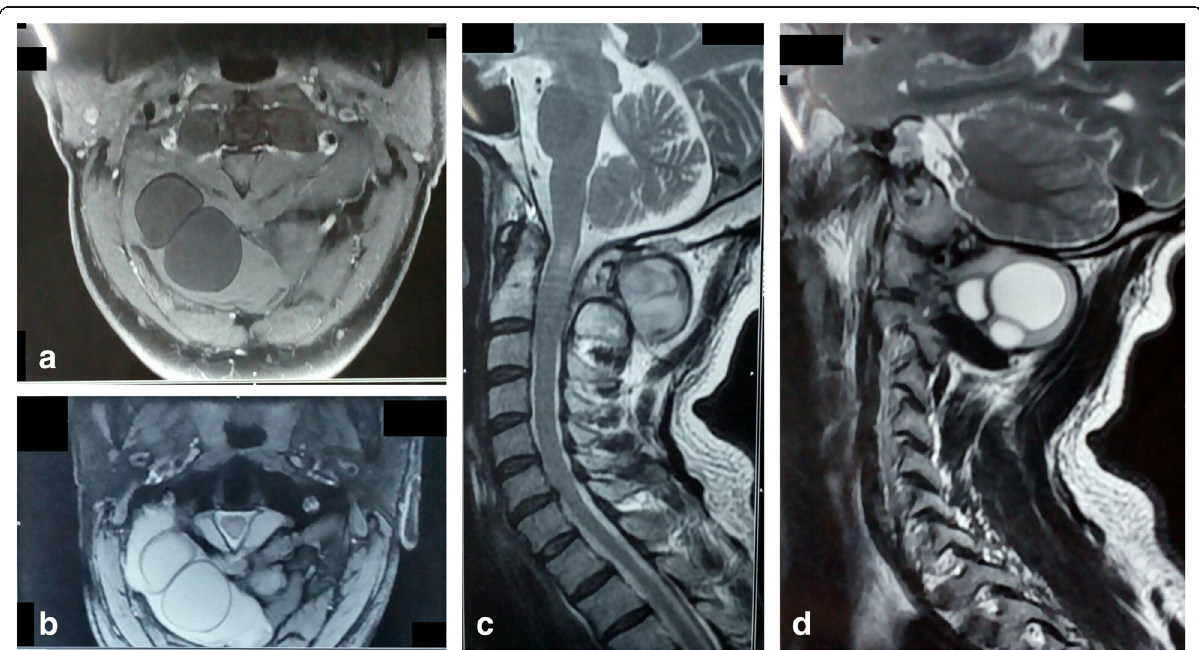
Fig. 2 a MRI neck (T1 weighted, axial view) showing cyst the in sub-occipital area. b MRI neck (T2 weighted, axial view) showing cyst in